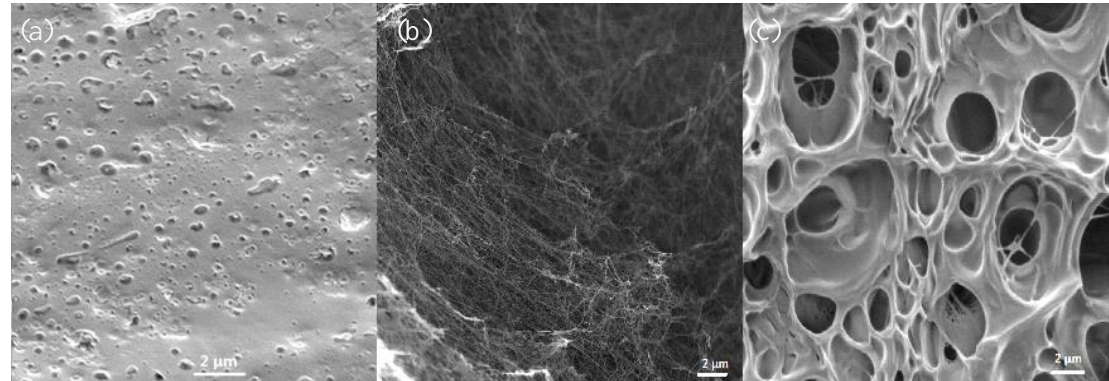
Figure 1. SEM images of ( a ) PAA, ( b ) BC, and ( c ) BC-PAA.